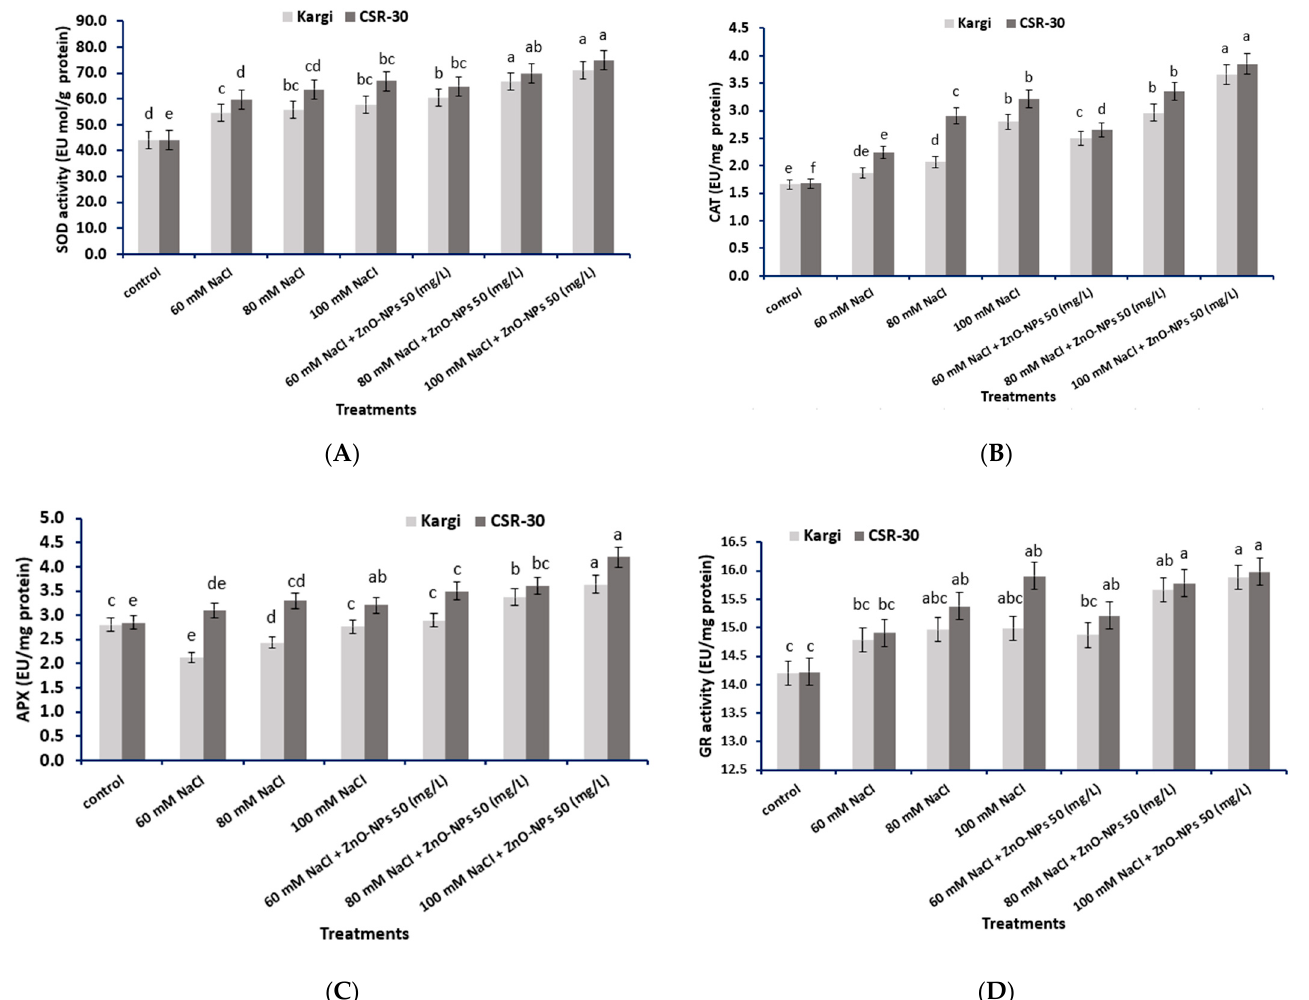
Figure 7. Impact of ZnO-NPs on antioxidant enzymes ( A ) SOD, ( B ) CAT, ( C ) APX, and ( D ) GR activity in leaves of Kargi and CSR 30 Oryza sativa genotypes in control and under saline conditions. Different small alphabets (a–f) indicate a statistically significant difference between treatments compared with control. Values are means of three replicates. Error bars indicate the least significant value (LSD) at p ≤ 0.01 among the treatments.